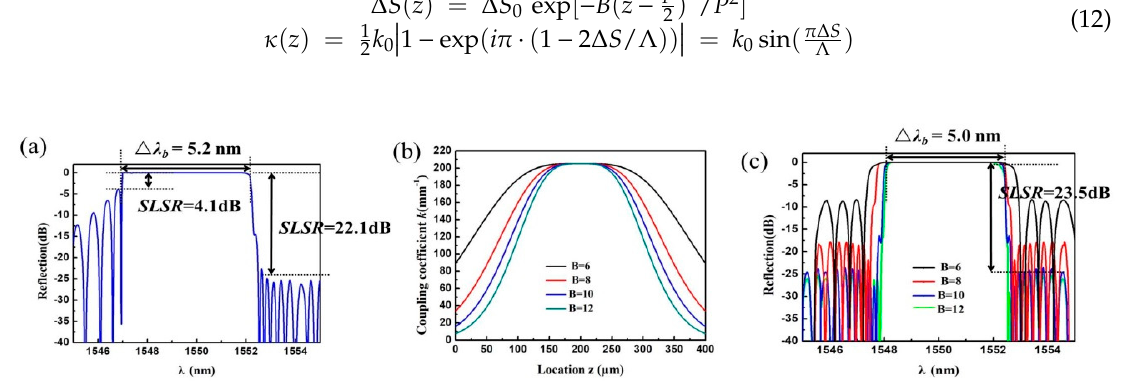
Figure 5. ( a ) Reflection spectrum of the traditional apodized grating; ( b ) Relationship of k and B in our proposed grating; ( c ) Reflection spectrum of the proposed apodized grating ( B = 6, 8, 10 and 12).